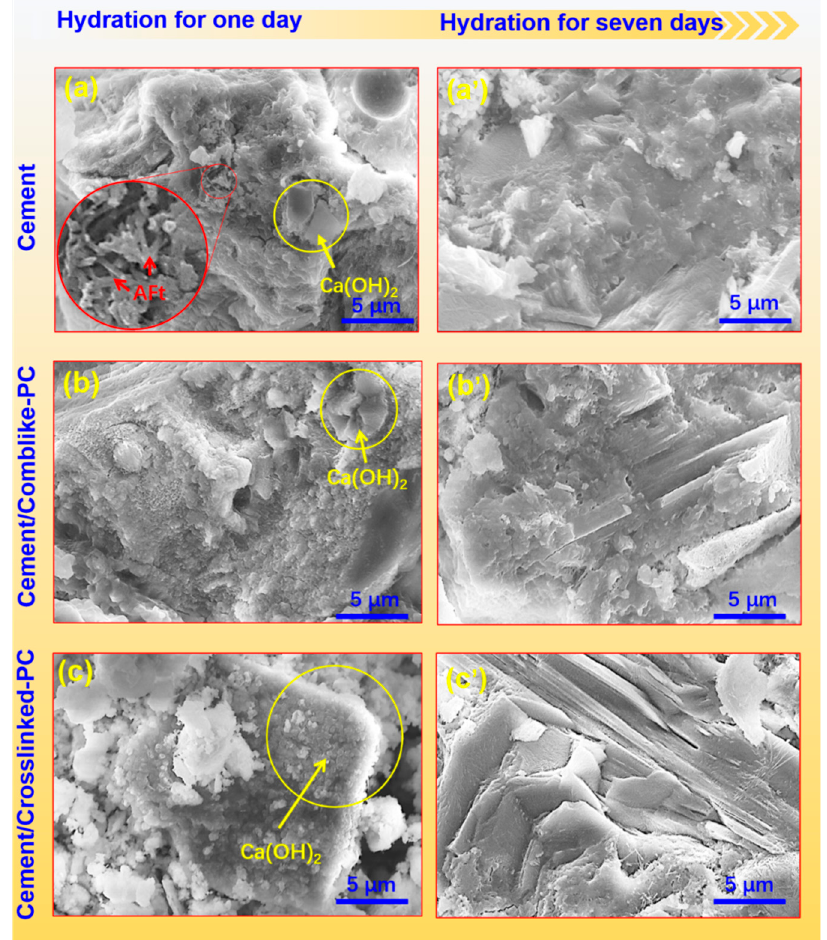
Figure 11. SEM micrographs of cement samples after hydration for 1 day ( a – c ) and 7 days ( a’ – c’ ) with a magnification of